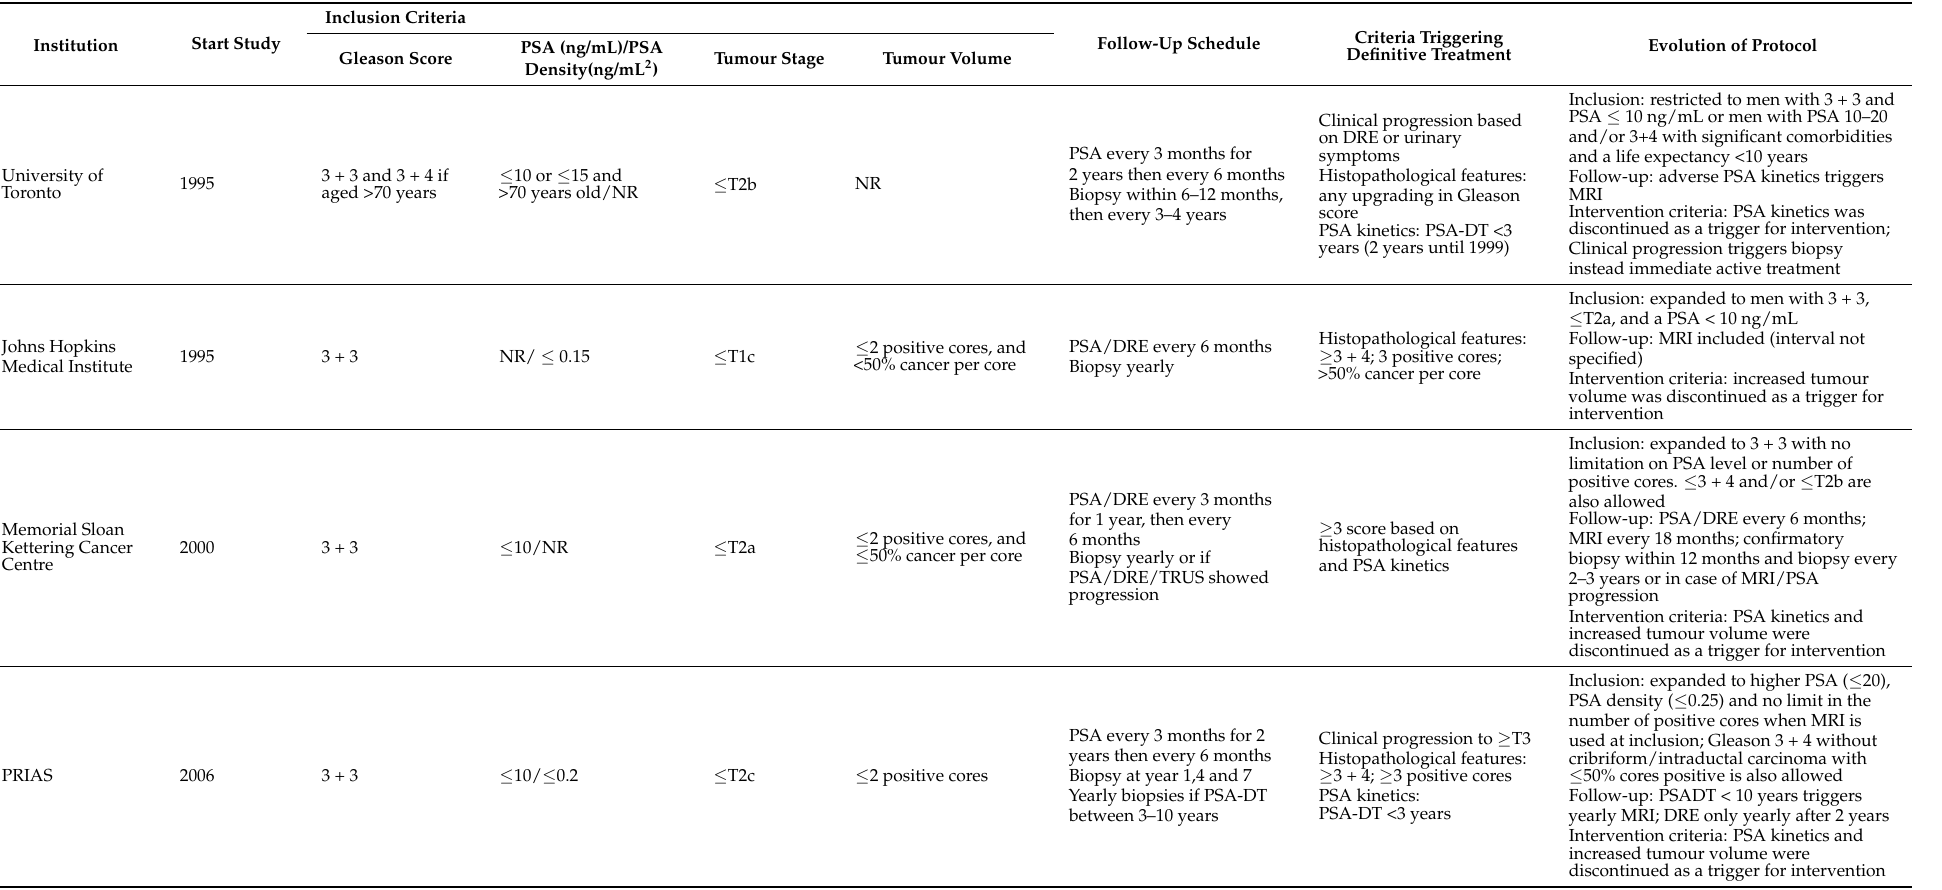
Table 1. Protocol-driven, prospective active surveillance